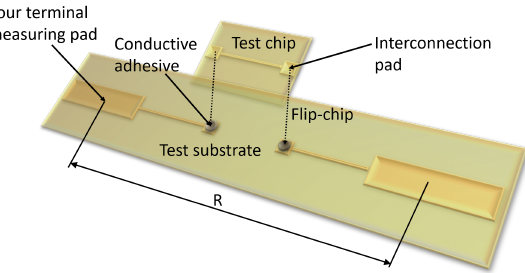
Figure 10. One connection of test vehicle flip-chip mounting.